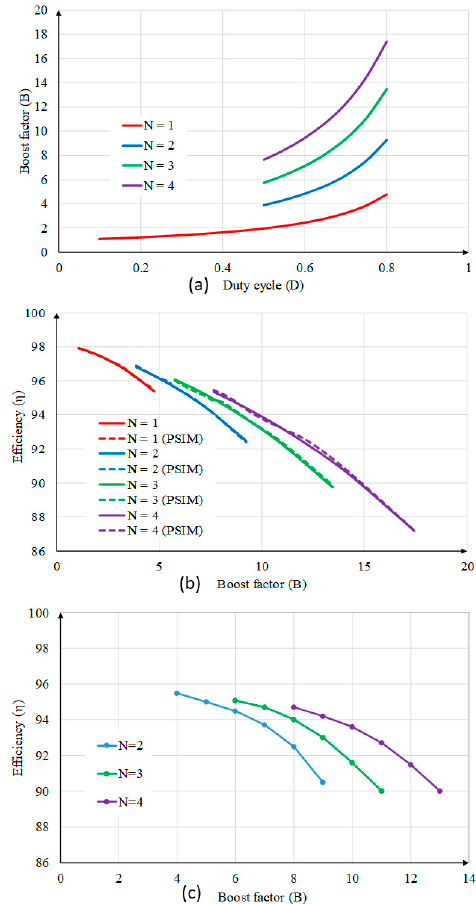
Figure 10. Boost ratio B ( a ), Efficiency η in calculated - simulation ( b ) and experiment ( c ) at Po = 1000 W.